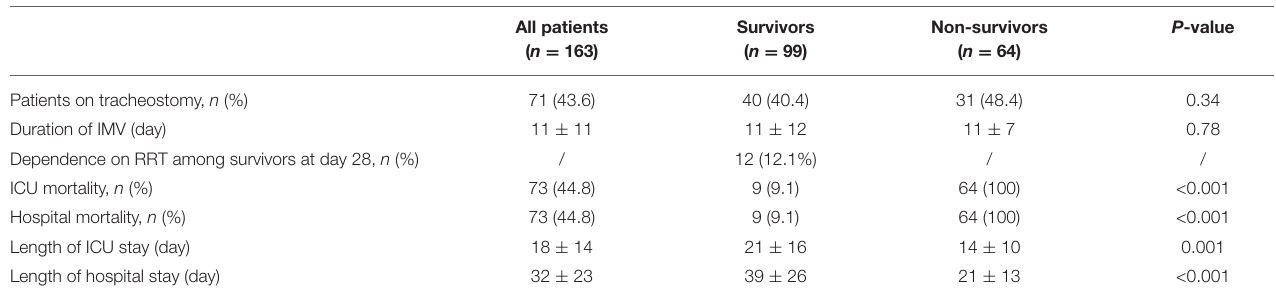
TABLE 3 | Clinical outcome grouped by 28-day